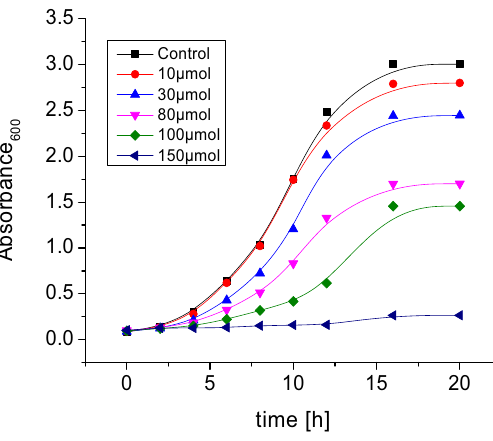
Figure 6: Growth curves of S. cerevisiae during a 24 h cultivation in the presence of 10; 30; 80; 100; and 150 μ M of complex 1 .